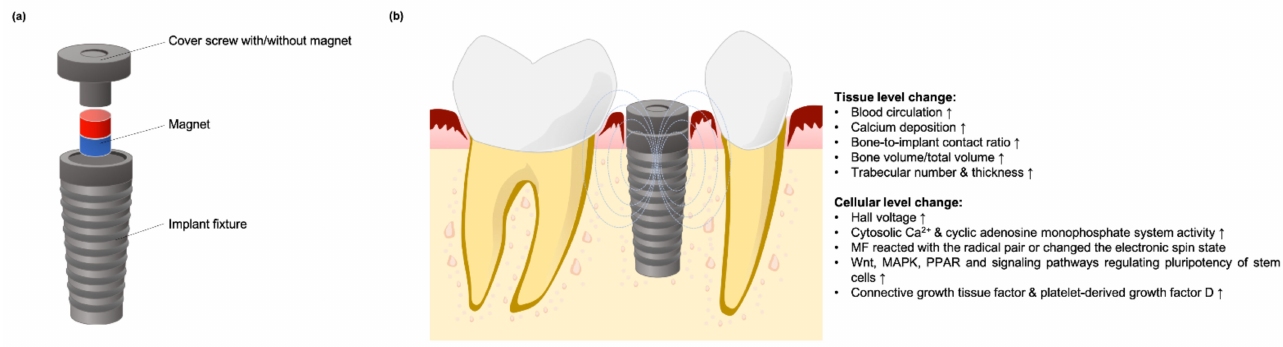
Figure 7. Illustration of a magnet-incorporated dental implant. ( a ) Diagram of implant structure with a magnet rod inserted inside the fixture; ( b ) After implantation into alveolar bone, the magnetic flux stimulated bone tissue and cellular change to enhance